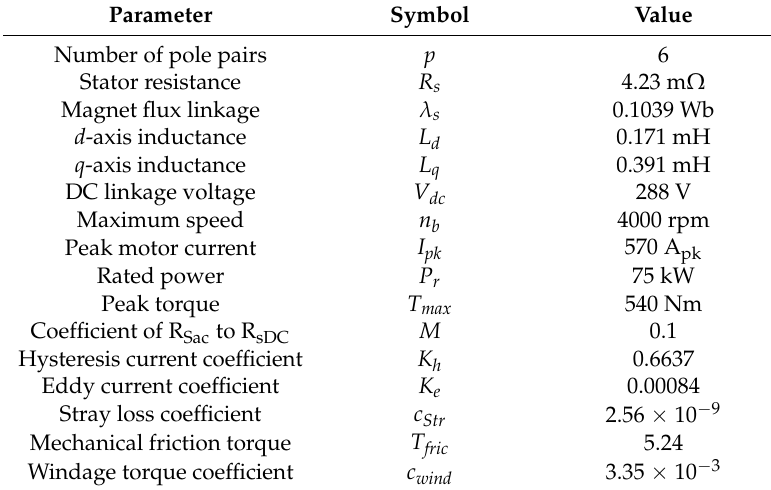
Table 2. Parameters of the Permanent Magnet Synchronous Motor